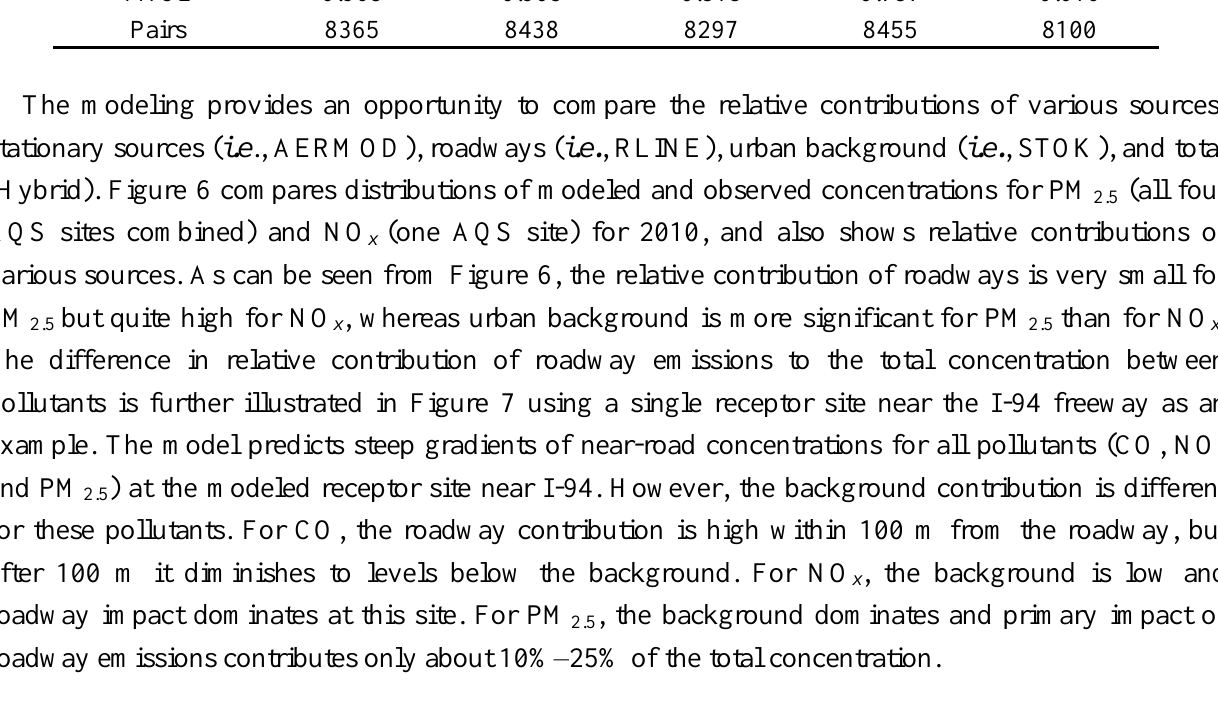
Figure 6. Distributions of modeled and observed PM the AQS monitoring sites. (all four PM